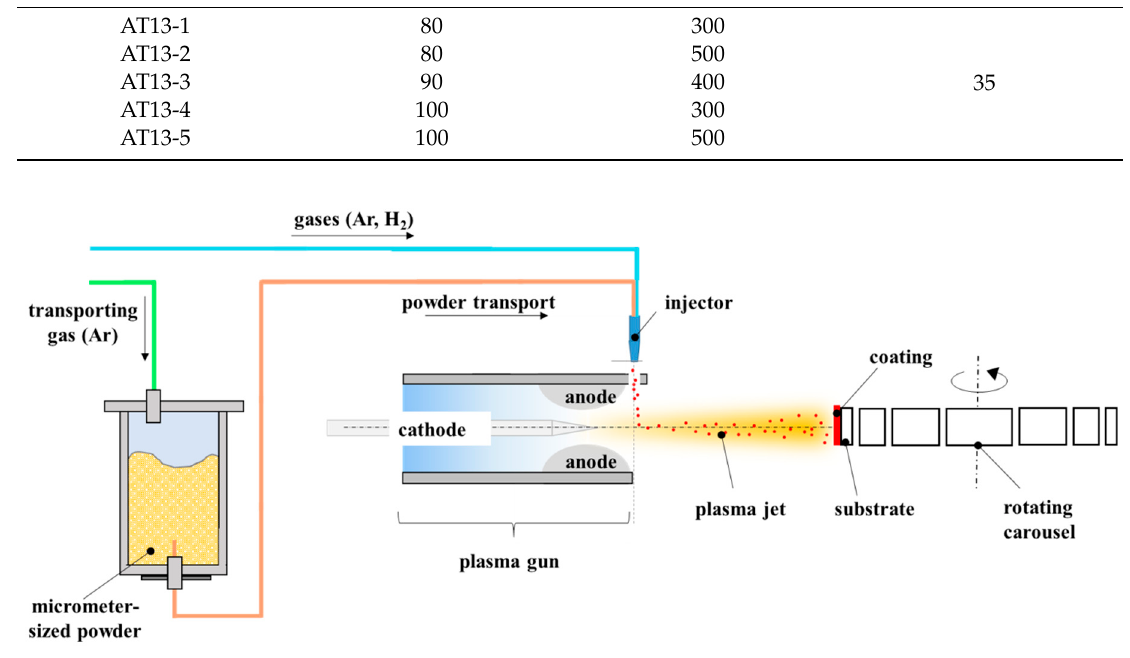
Figure 2. The spray process configuration scheme (inspired by [22] copyright Elsevier 2008).